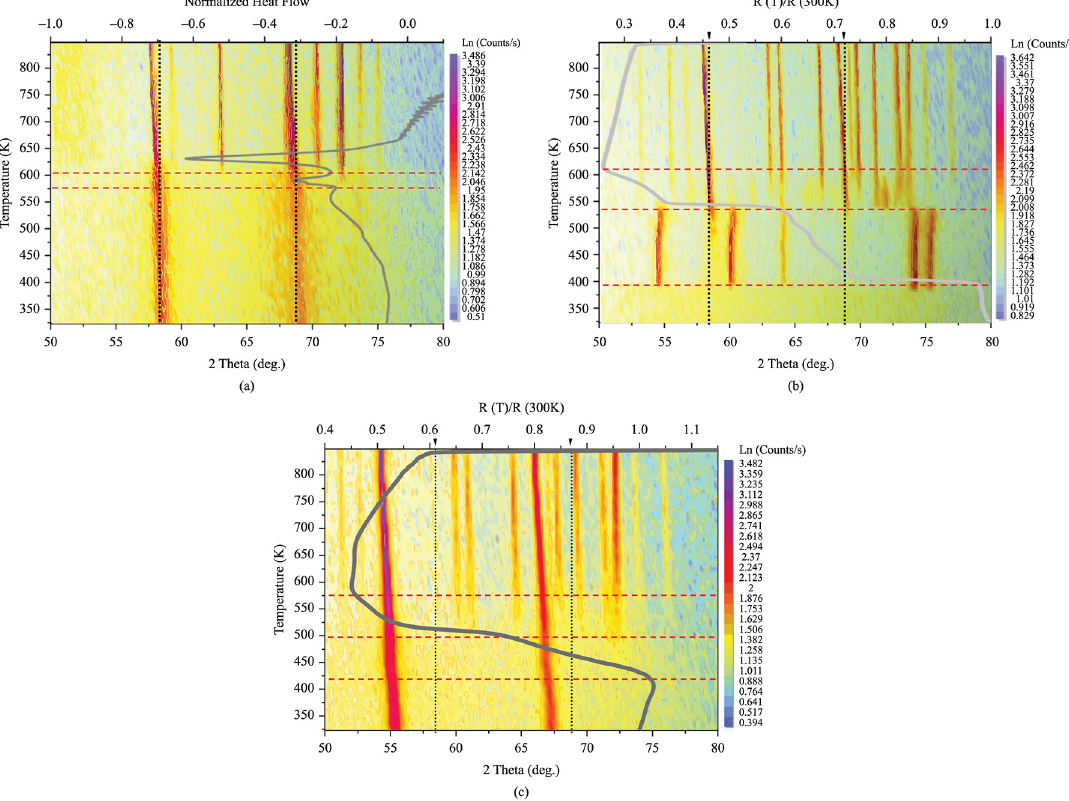
Figure 6. Overview of XRD patterns of Al to 853K. Inset shows DSC curve (a) and resistivity curve (b and c). Dotted lines mark fcc-Al phase